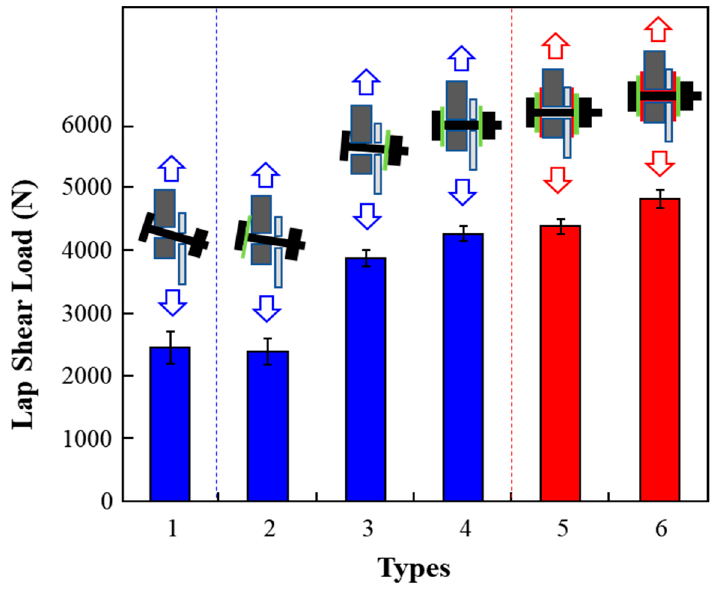
Figure 5. Lap shear load of the CFRP and steel joined by bolting in different cases.